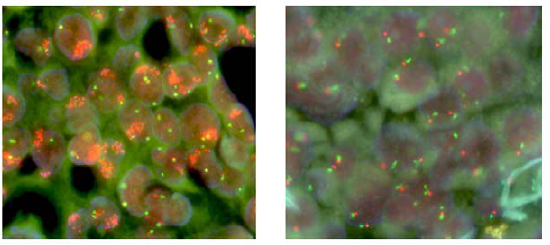
Figure 4. EGFR copy number was determined by FISH. Evaluation of EGFR gene copy number by FISH was done using the EGFR (orange)/ CEP 7 (green) probe (Beijing GP medical Tec., LTD, China). Panels illustrate tumor specimens representing gene amplification (A) and disomy (B).